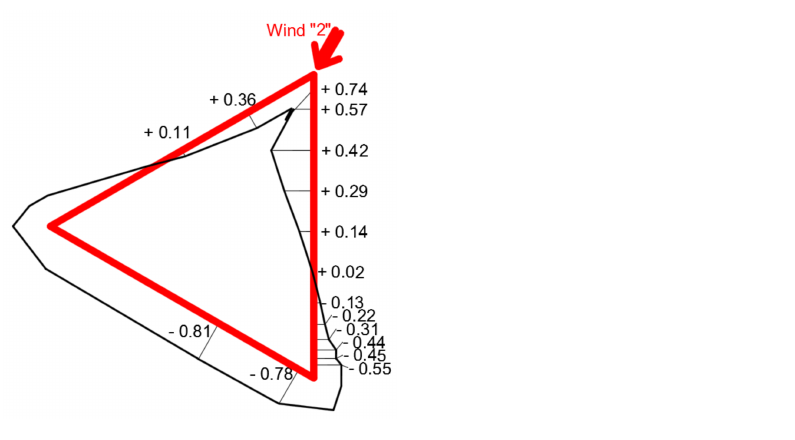
Figure 6. External pressure coefficient Cp [ − ] obtained experimentally for wind flow direction